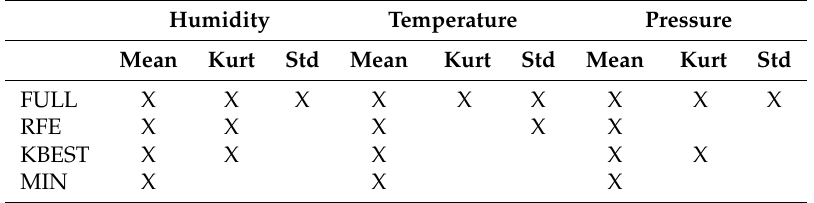
Table 7. Subsets of features for the living room dataset. An X indicates a selected